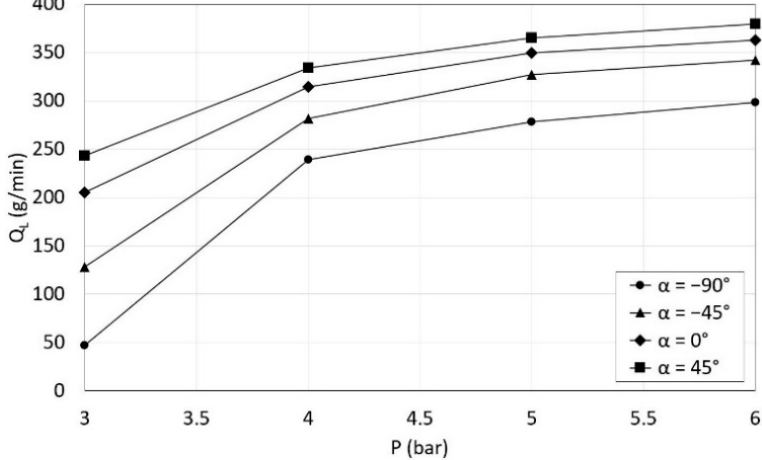
Figure 6. Liquid output Q L as a function of pressure P and stub regulation angle α .